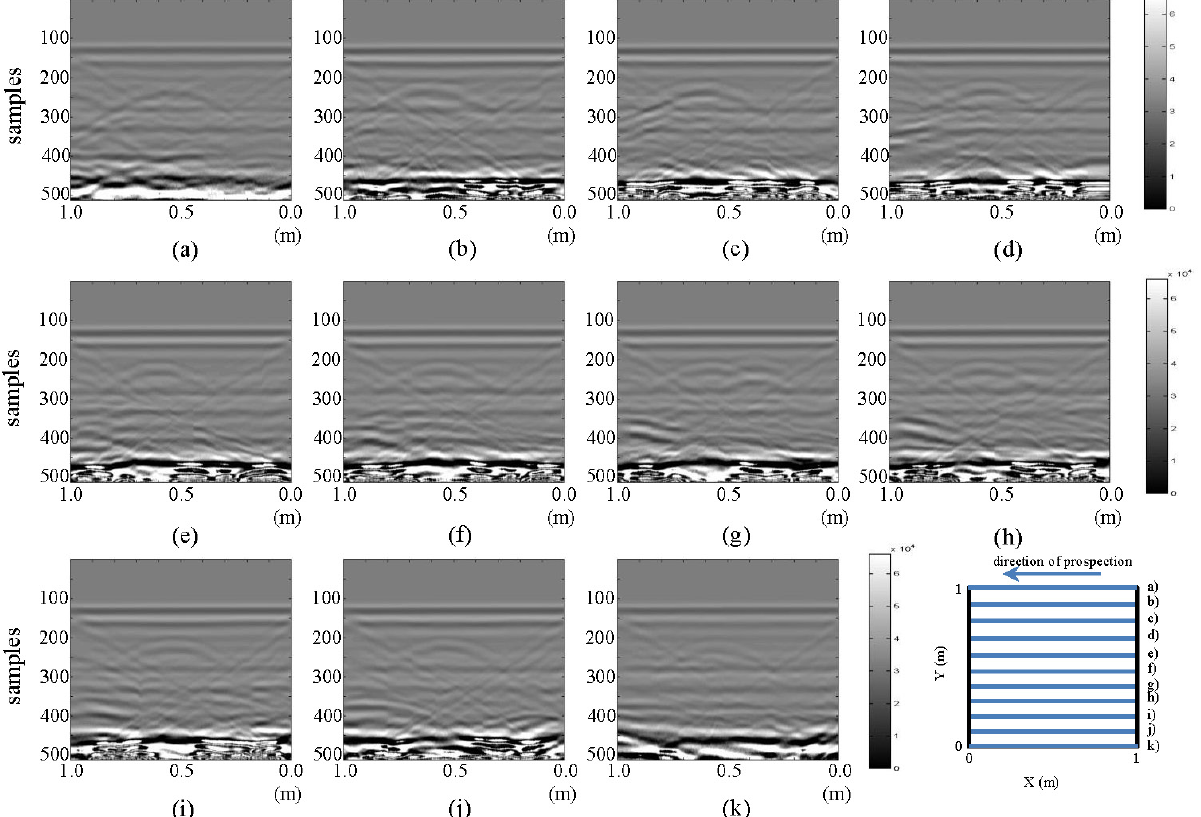
Figure 3. Horizontal profiles: raw images for the initial state. ( a – k ) are profiles s1 to s11,